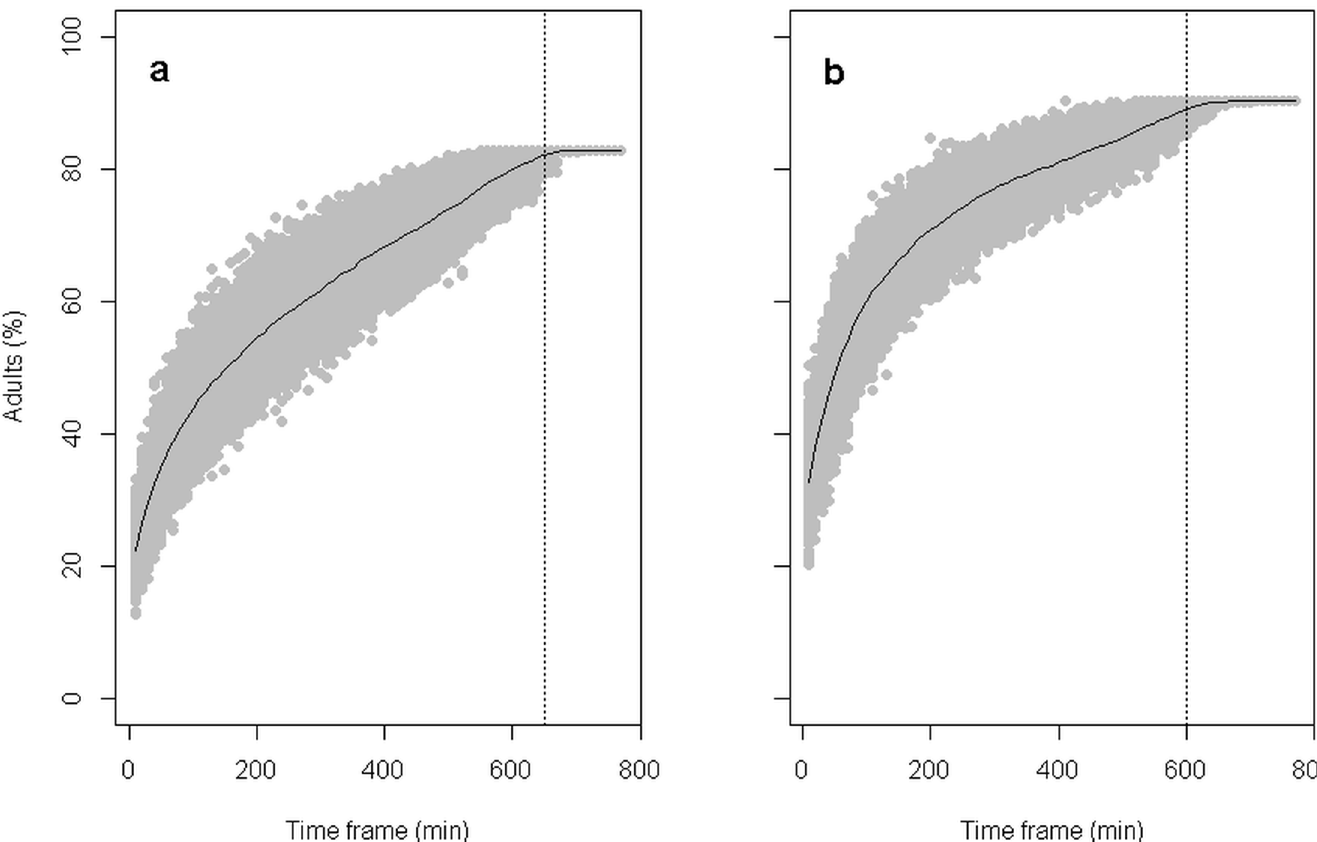
Fig 4. Percentage of the maximum number of adults observed in random time-frames of increased duration. Panels a and b show the mean percentages of the maximum number of adults observed in each warren in the three days of surveillance for all warrens and only for warrens with resident pups (active warrens), respectively. Vertical dotted lines indicate the shorter time frame when the percentage observed ranged within 0.05 of the asymptotic value.